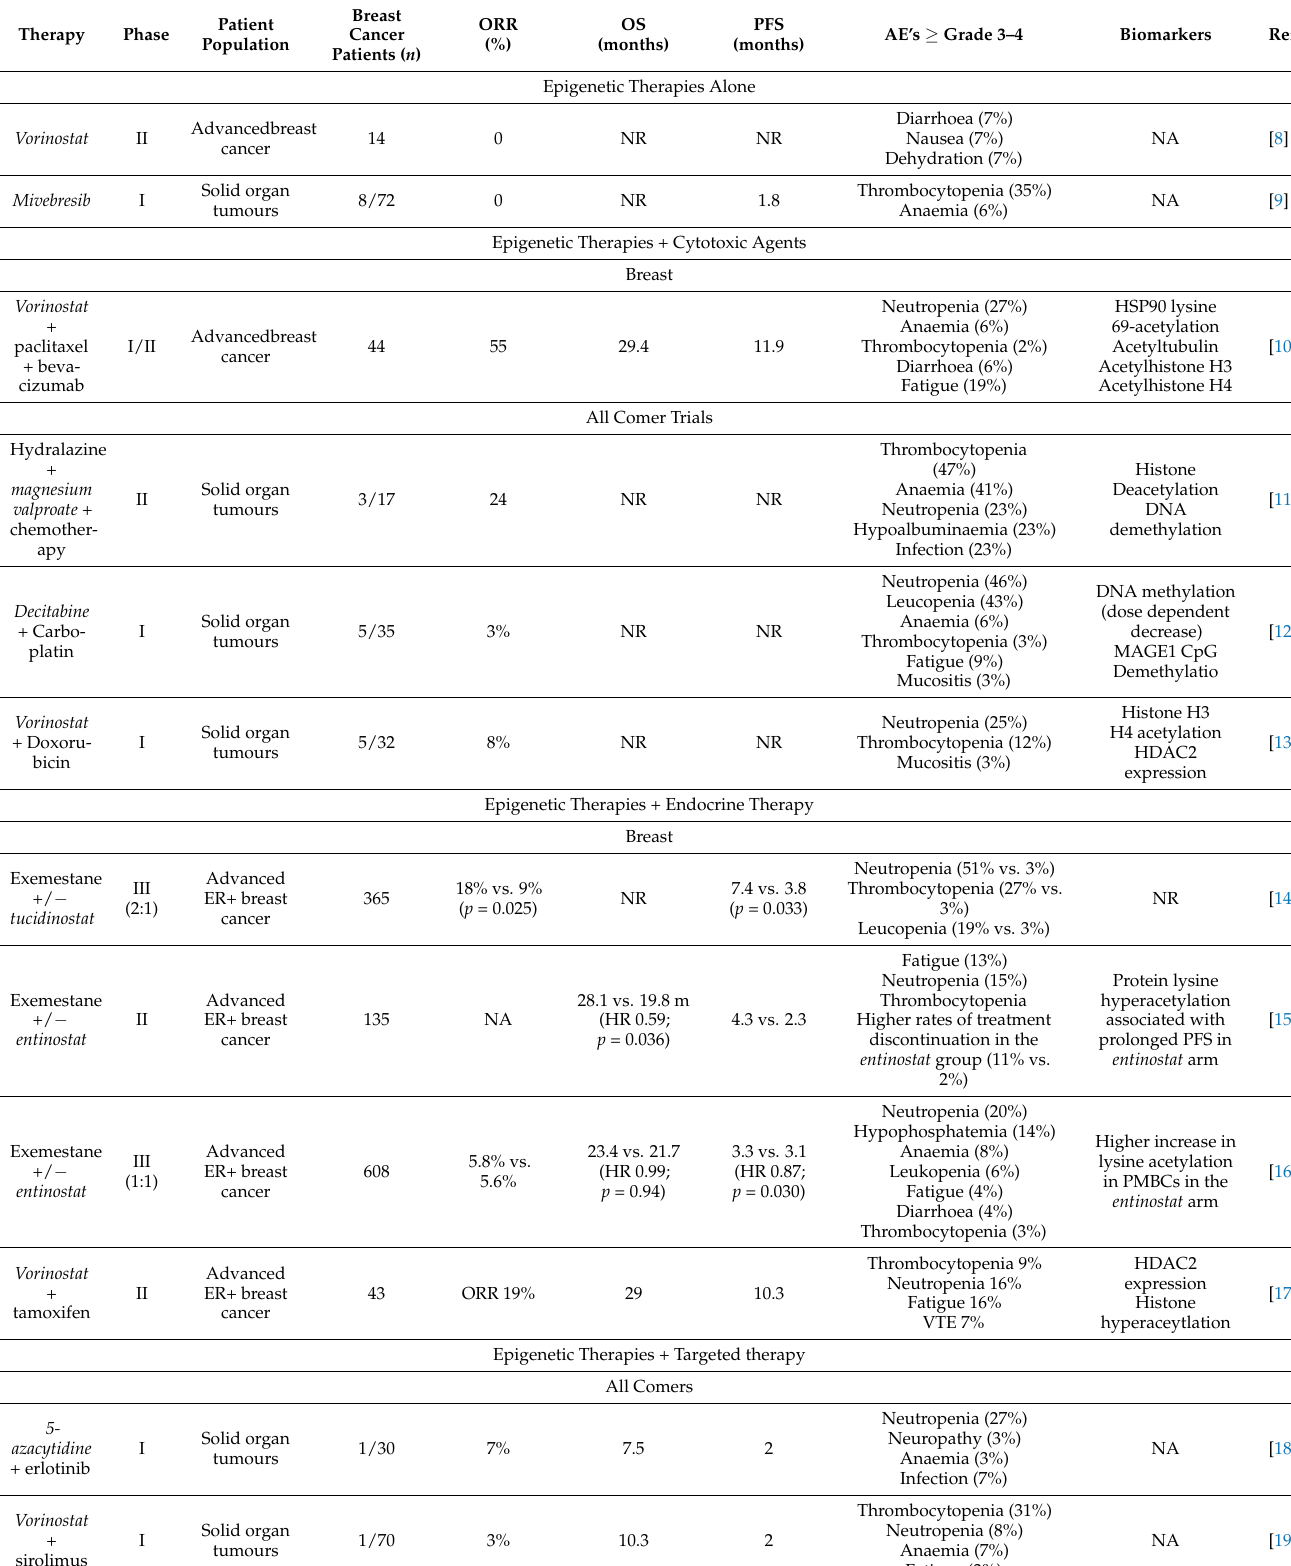
Table 1. Completed Trials of Epigenetic therapies in Breast Cancer (Adapted with permission)